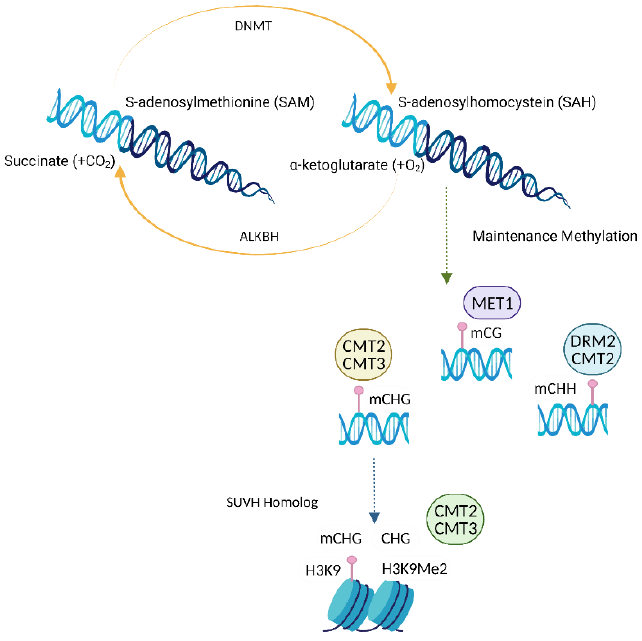
Figure 1. Maintenance of methylation and demethylation in plants.